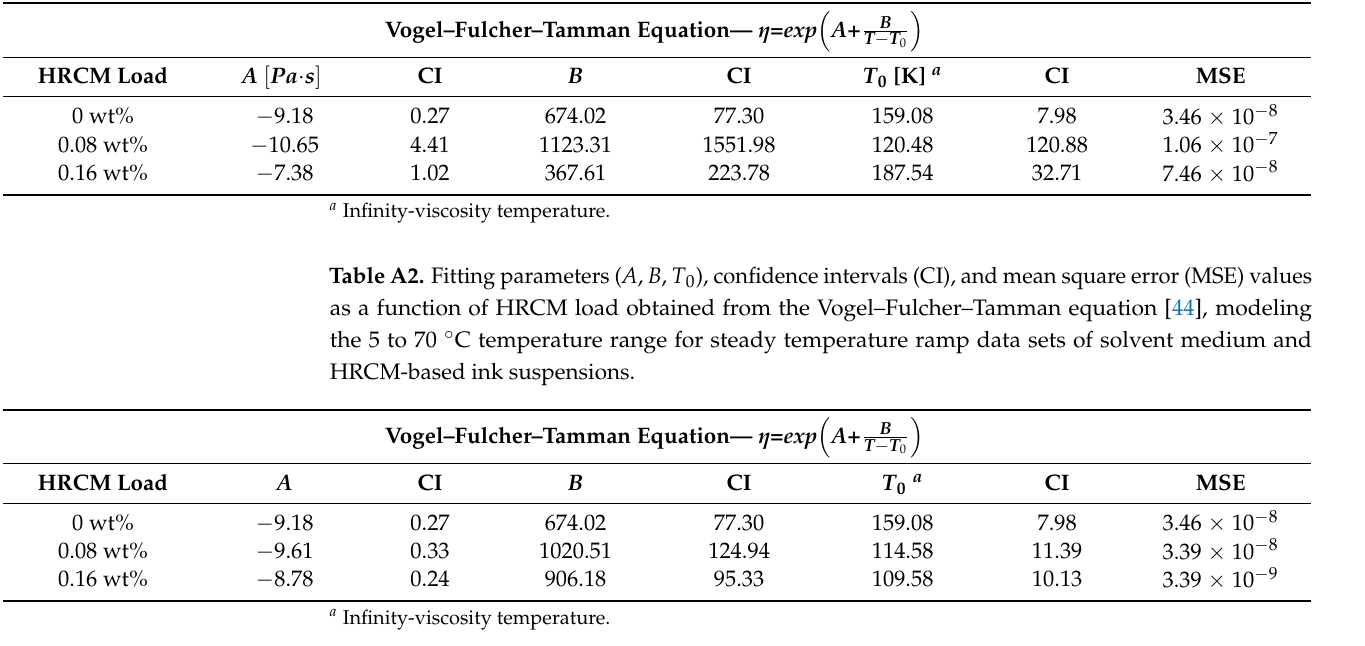
Table A1. Fitting parameters ( A , B , T 0 ), confidence intervals (CI), and mean square error (MSE) values